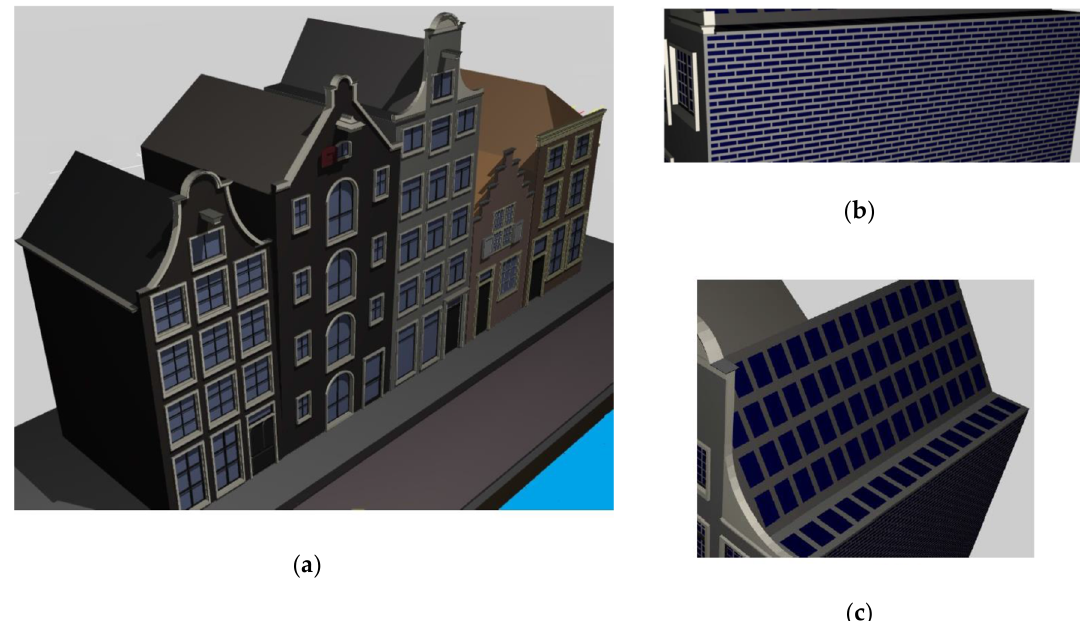
Figure 2. Amsterdam canal house ( a ), the subject is the highest building (middle), the brick-form BIPV panels ( b ) and tiles representative of the roof tiles ( c ). The curved structure of conventional tiles is ignored for the computational purposes.